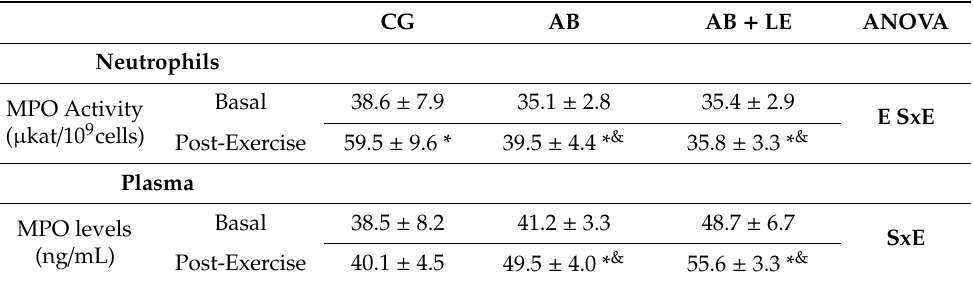
Table 7. MPO enzymatic activity in neutrophils and plasma levels determined in basal conditions and immediately after the 2000-m test in control (CG), almond beverage (AB) and almond beverage + Lippia extract (AB + LE)